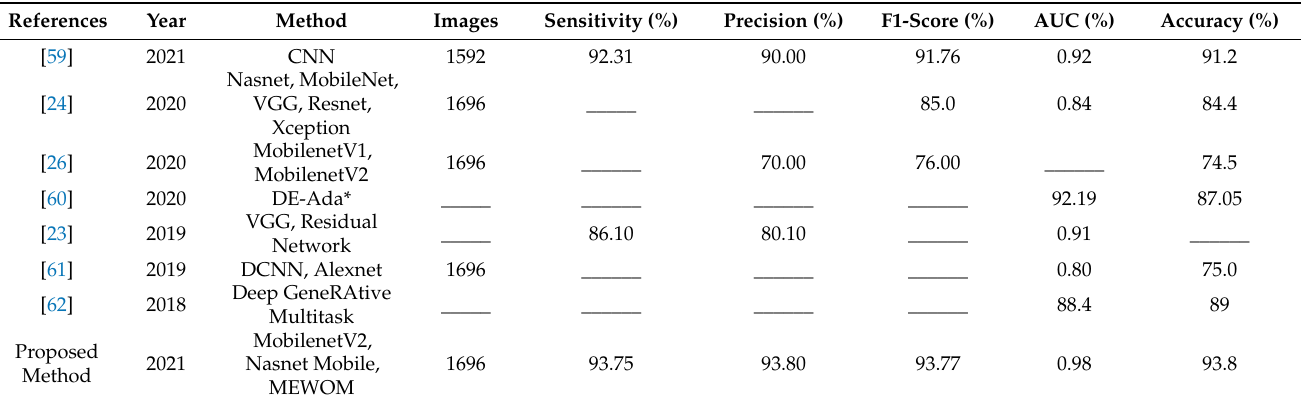
Table 20. Comparisons with state of art CBIS-DDSM dataset.